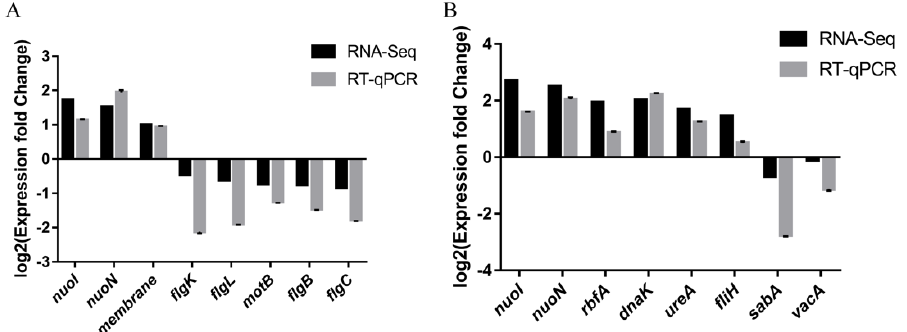
Figure 9. Validation of RNA-Seq by RT-qPCR on selected DEGs. FIC group: 1 × FIC of AMX and CLR, CF7 group: 6.25% CFS of 10 7 CFU/mL L. salivarus LN12 in combination with 1 × FIC of AMX and CLR, CF9 group: 6.25% CFS of 10 9 CFU/mL L. salivarus LN12 in combination with 1 × FIC of